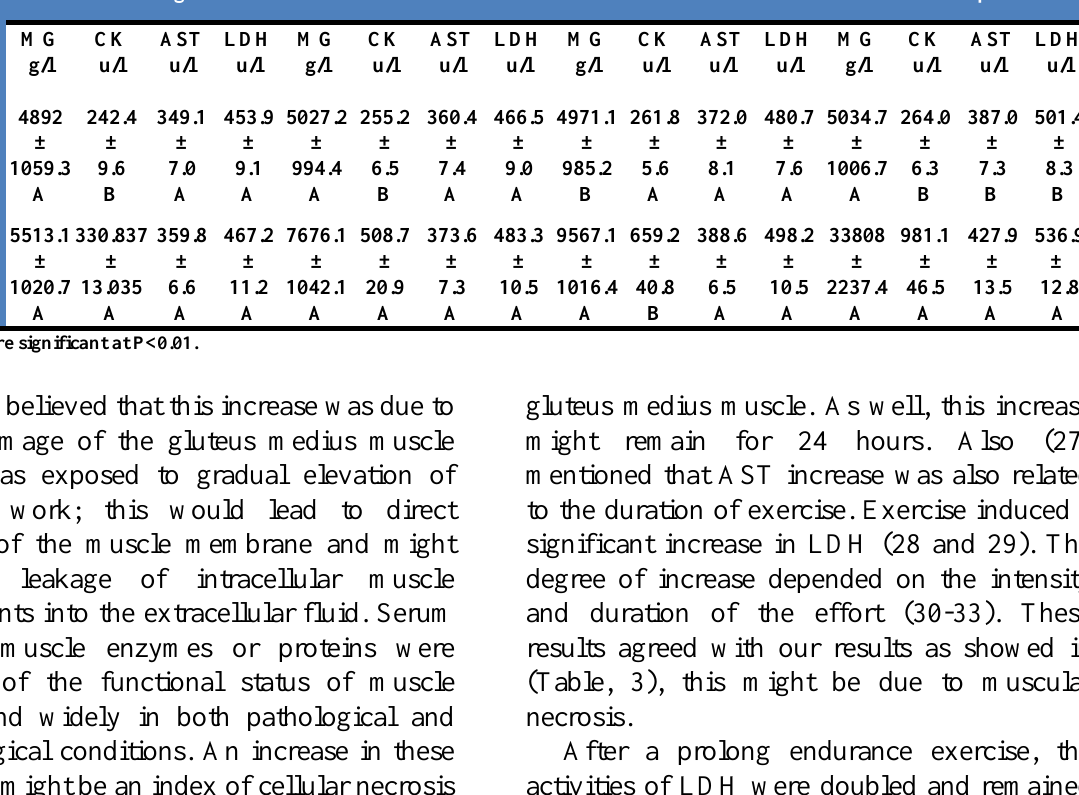
Gallop Canter Trot Walking